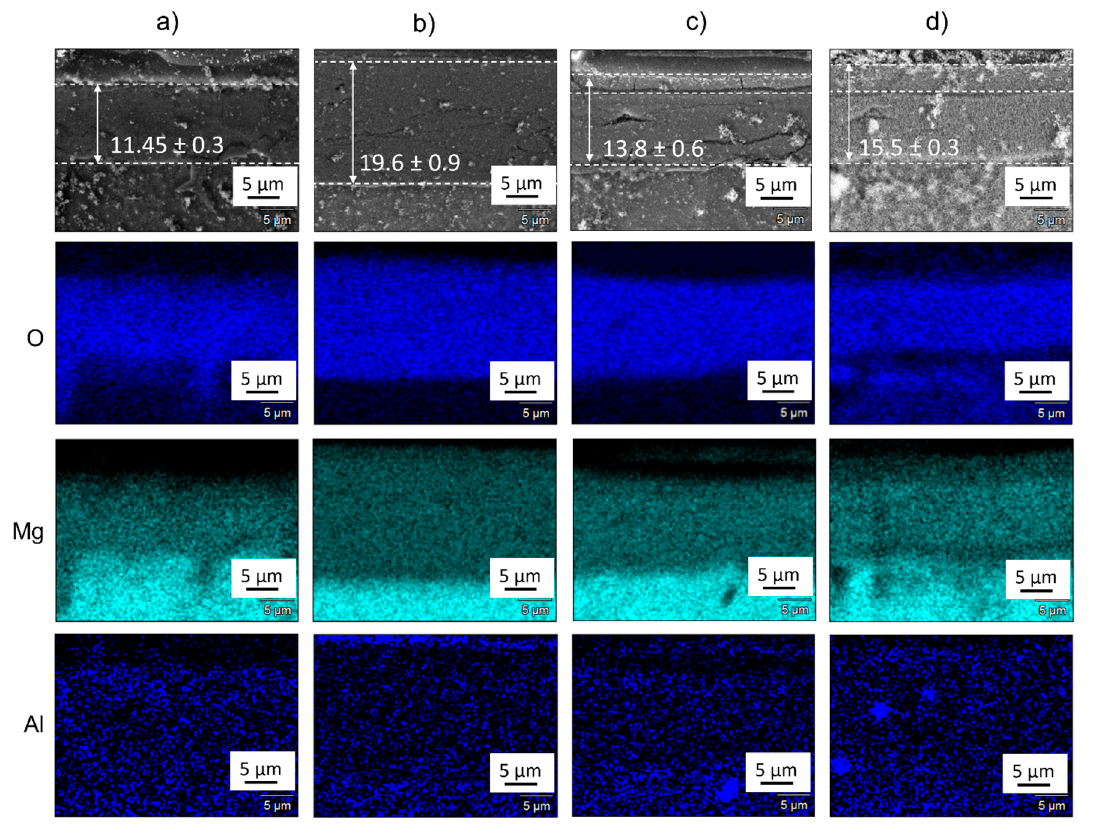
Figure 17. EDS mapping of the cross-section of samples without Al(NO 3 ) 3 on ( a ) etched at pH = 10, ( b ) etched at pH = 11, ( c ) anodized at pH = 10, ( d ) anodized at pH = 11.